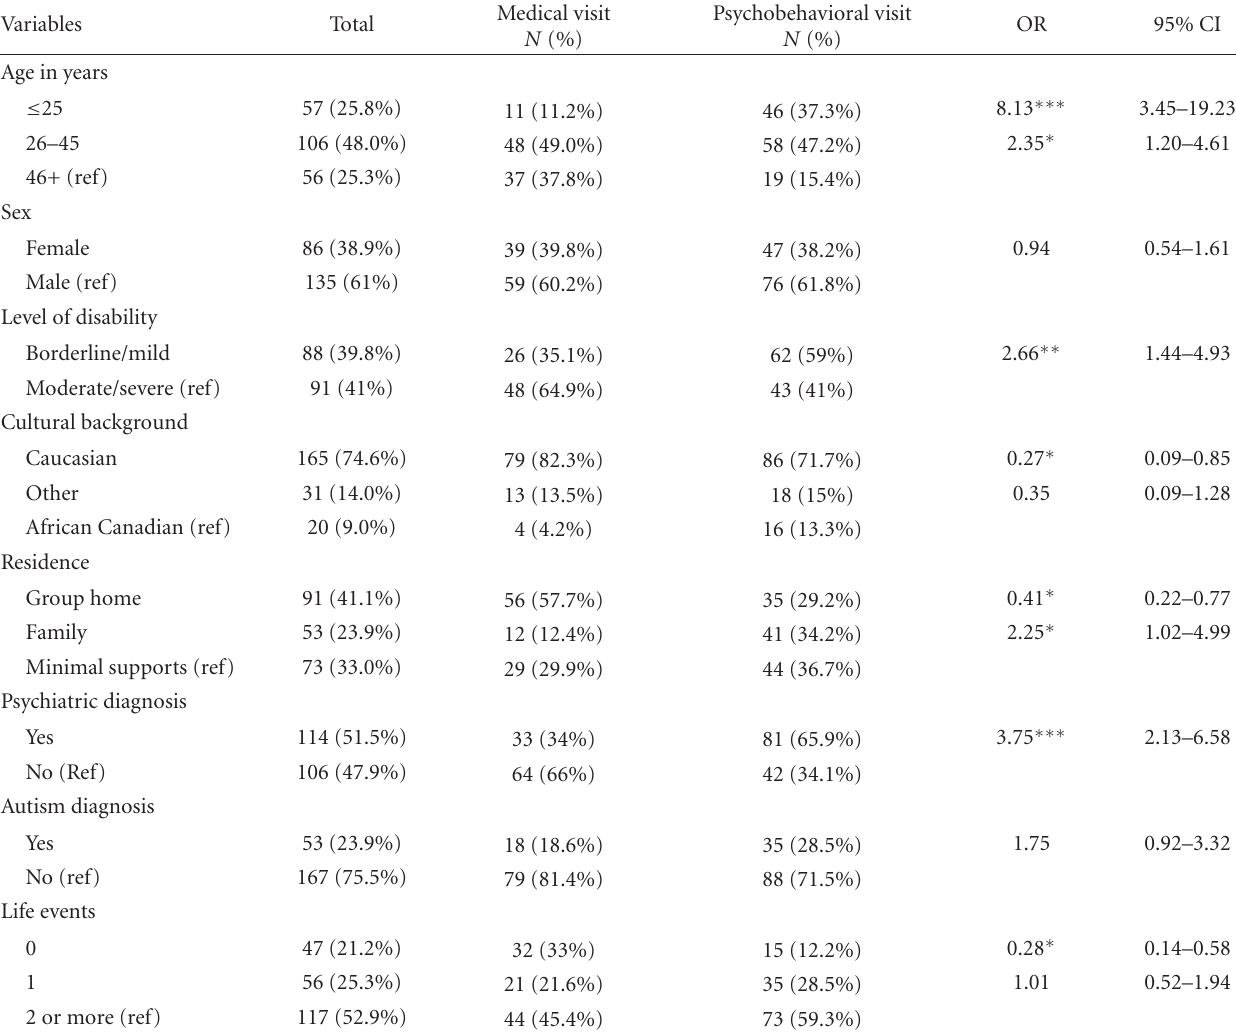
Table 2: Unadjusted odds ratios of association between variables and type of emergency visits (psychobehavioral versus medical crisis).